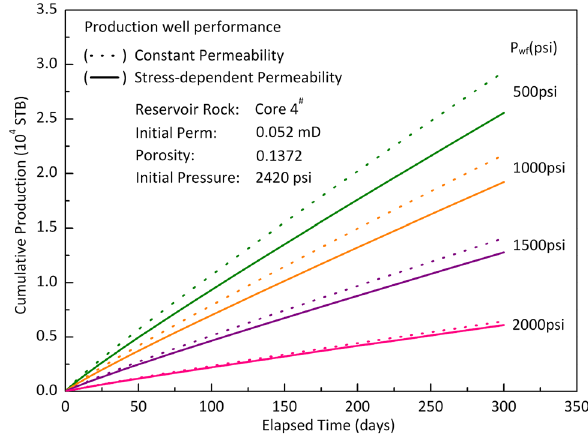
Fig. 5 Cumulative production under different producing